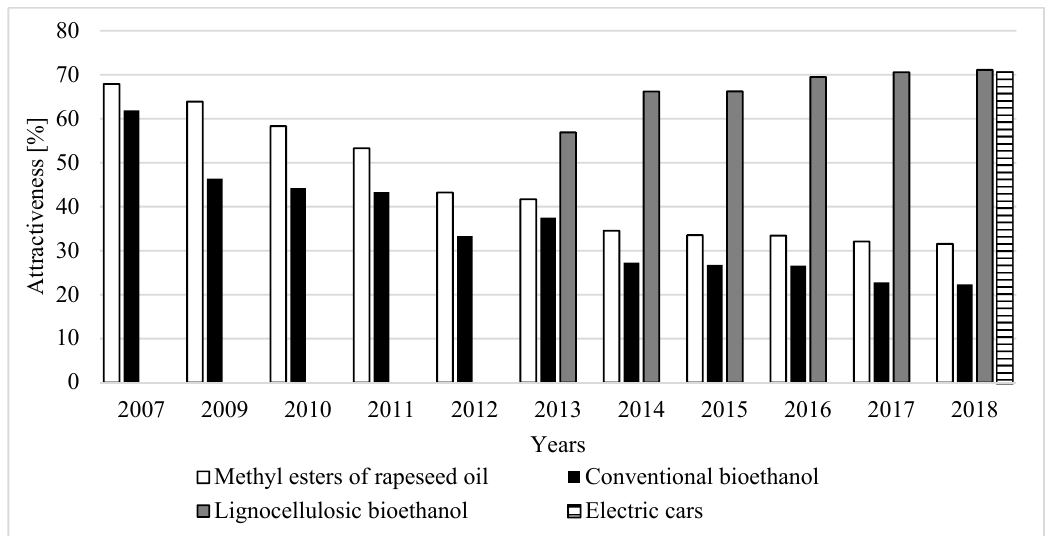
Figure 2. Attractiveness of selected sectors in Poland in years 2007–2018 (%). Source: Own research for years 2007–2018.